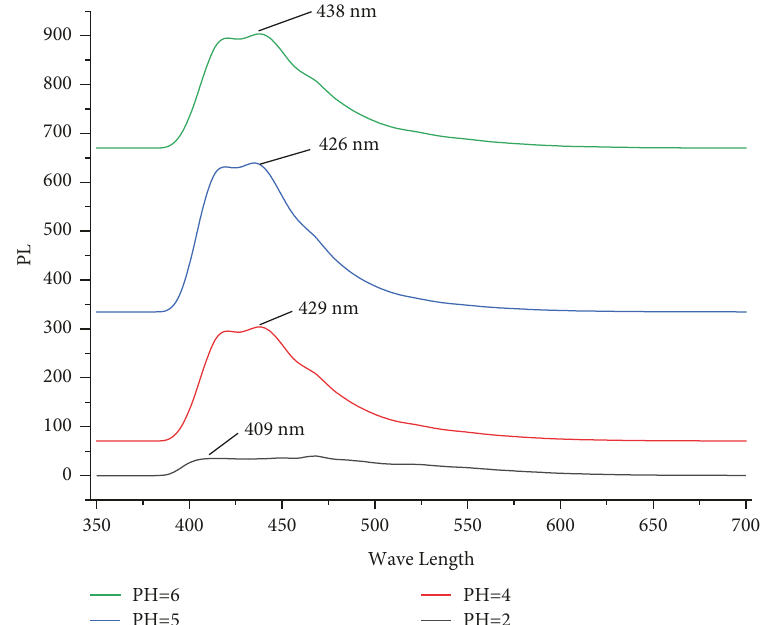
Figure 5: Photoluminescence spectra of prepared Fe TiO (EDS)